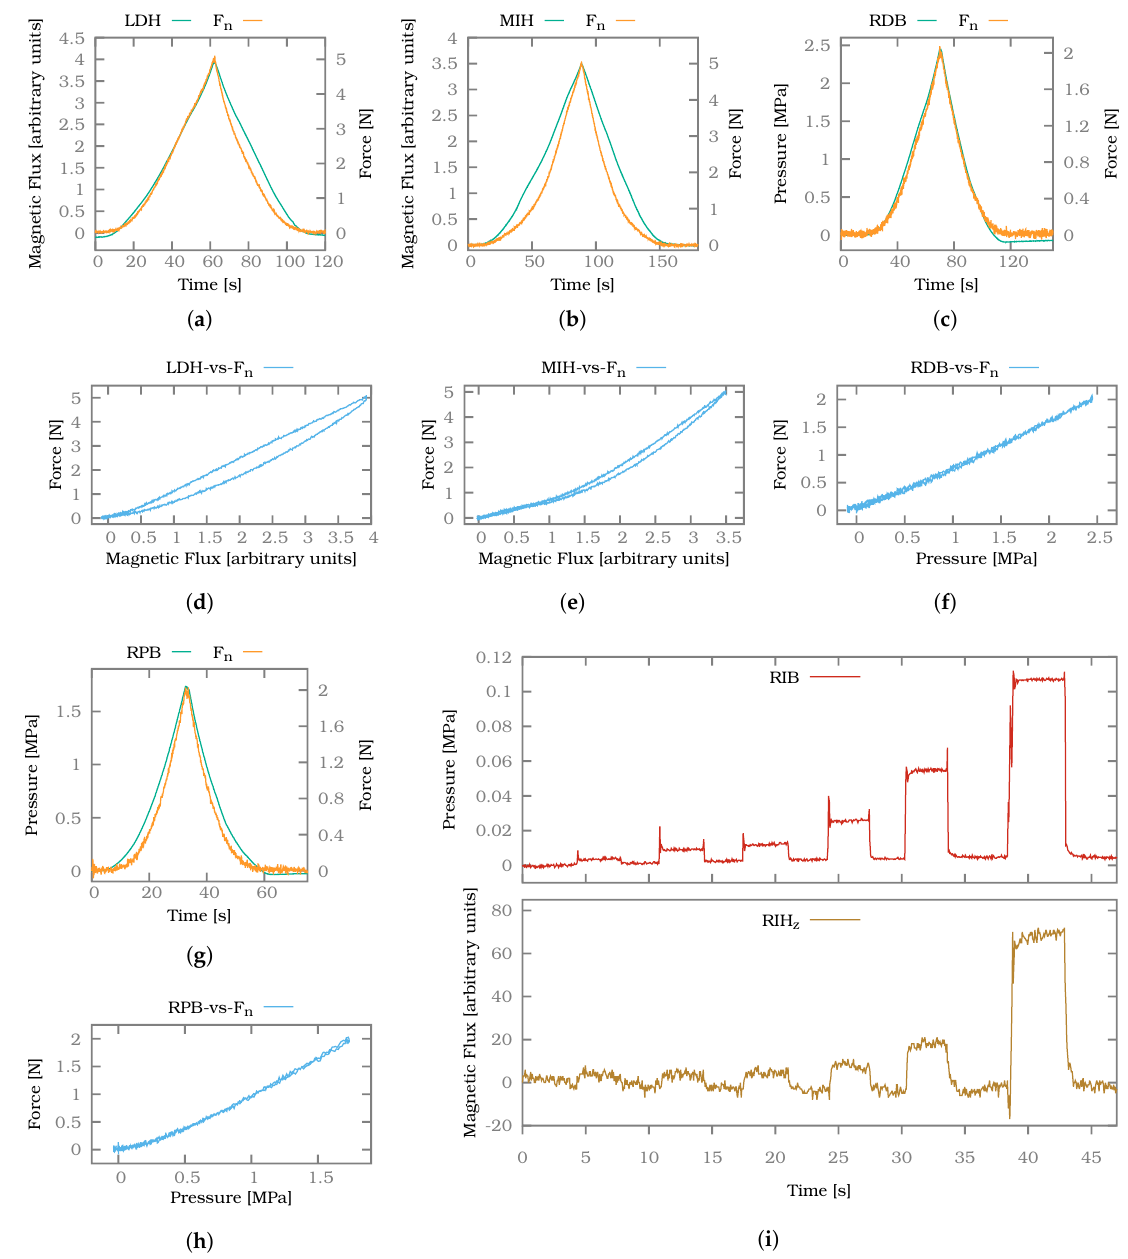
Figure 11. ( a , b ) Normal force measurements for Hall effect-based sensors. ( d , e ) Corresponding hysteresis plots. ( c , g ) Normal force measurements for the barometer-based normal force sensors. ( f , h ) Corresponding hysteresis plots for the barometer-based sensors. ( i ) Weights distributed on a